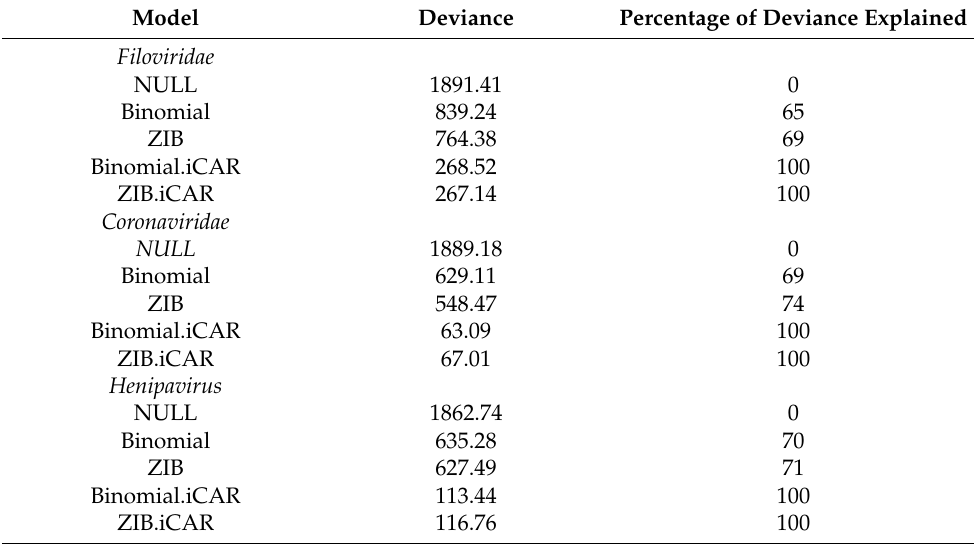
Table 1. Model deviance with the percentage of deviance explained by a predictor variable.